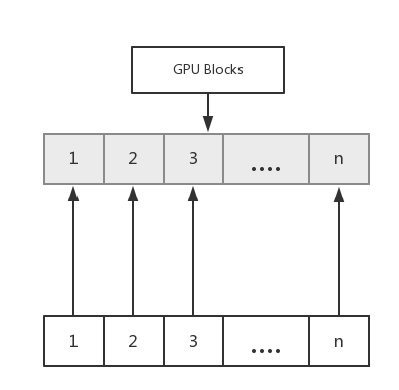
Fig. 2. GPU blocks mapping in a grid, variable n represents the size of the array variable, which is need to copy onto the GPU